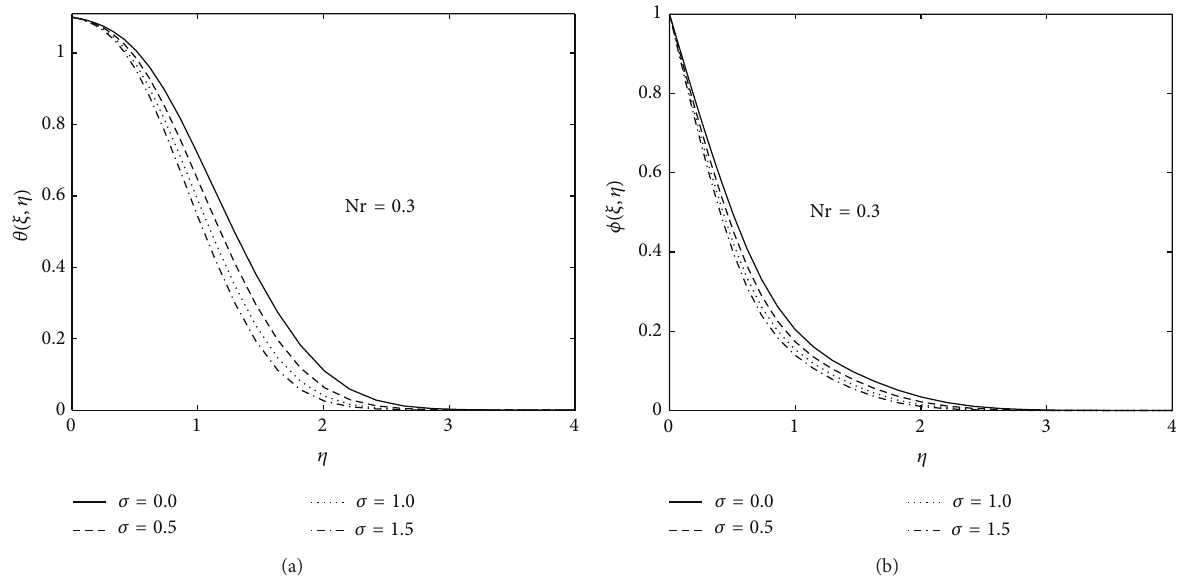
Figure 3: Effect of the 𝜎 on 𝜃(𝜂) and 𝜙(𝜂) for 𝑥 = 0.5 , Le = 10 , Pr = 7 , 𝐴 = 0.1 , Nr = 0.1 , Nt = 0.1 , and Nb = 0.5 .